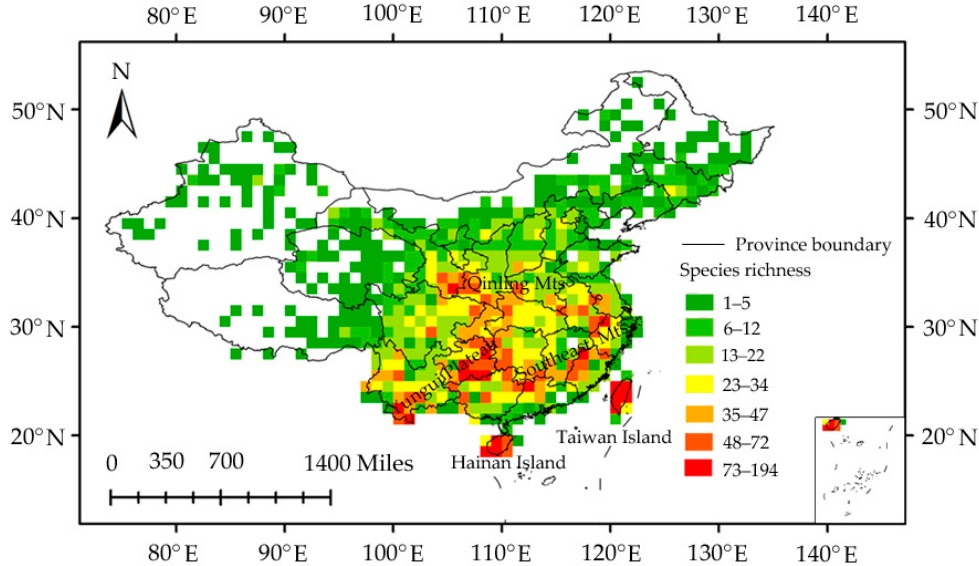
Figure 4. Planthopper species richness patterns in a 1° grid size.